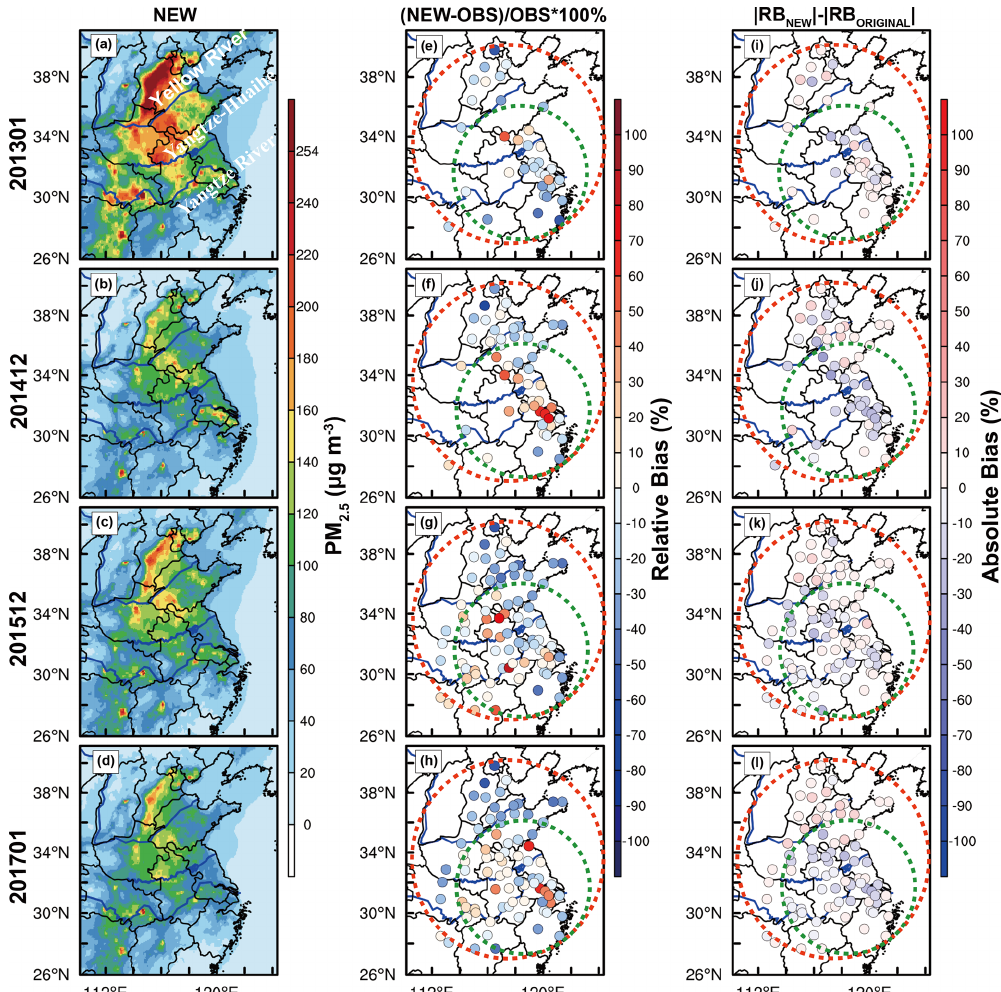
Figure 4. The average value of (a–d) simulated PM 2 . 5 concentration (µgm − 3 ) by new schemes, (e–h) the relative bias (RB, %) of PM 2 . 5 concentration between simulation of new scheme and observation and (i–l) the absolute bias (AB, %) between the new and original schemes. The calculation formula of absolute bias is AB = | RB new |− and original schemes, respectively. The dashed red and green circles represent the whole simulation area and eastern China,